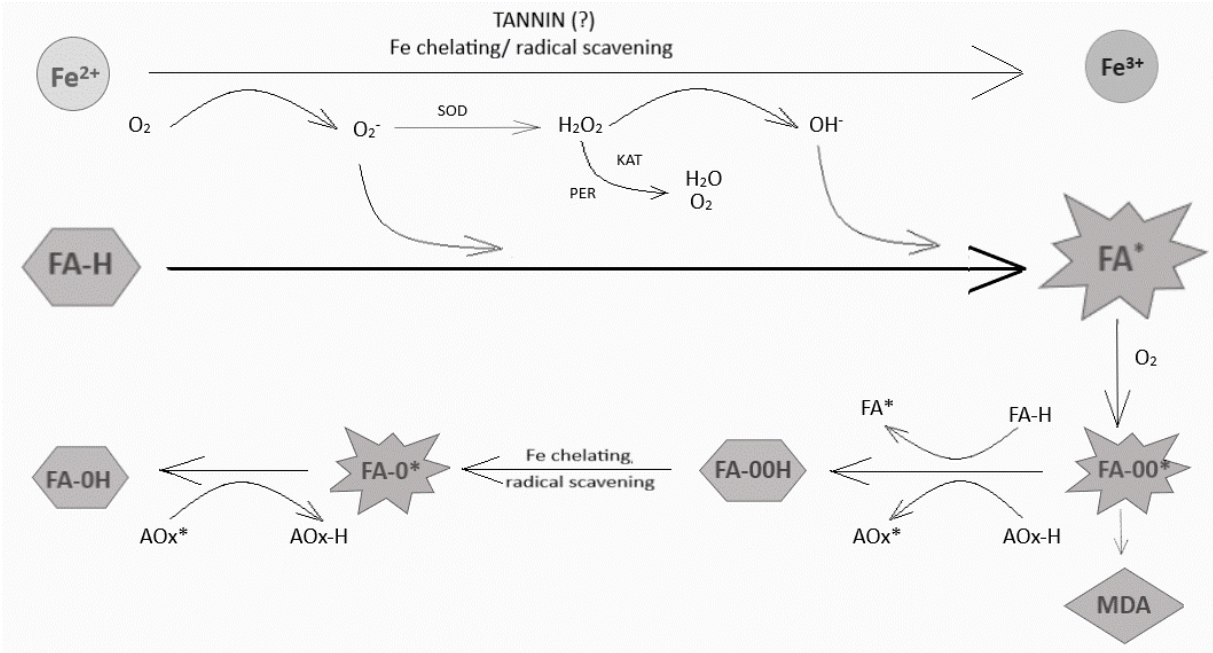
Figure 3. The process of lipid peroxidation (individual phases and the proposed involvement of antioxidants in combating this process). Lipid peroxidation phases: initiation, where the unsaturated fatty acid reacts with a radical-generating initiator; propagation, where the radical reacts with other fatty acids to propagate as a chain reaction; and termination, with highly concentrated radicals interacting with each other to obtain non-radical compounds. Hydrophilic compounds also play a role in inhibition of this process. SOD—superoxide dismutase, FA-H—unsaturated fatty acid, FA*—fatty acid radical, FA-OO*—fatty acid peroxide radical, AOx—antioxidant, MDA—malondialdehyde.